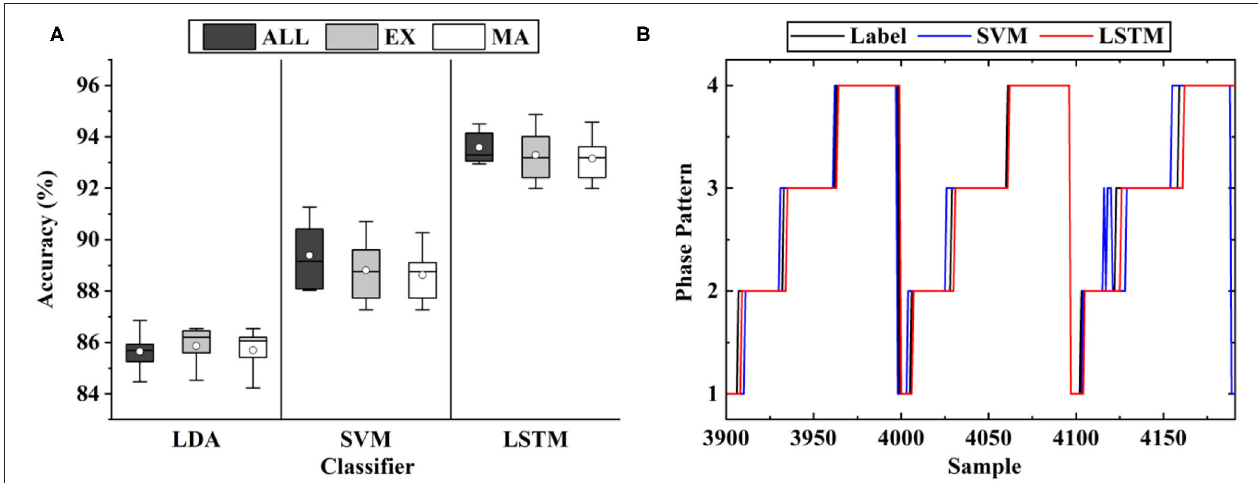
FIGURE 6 | The classification results of gait phases: (A) The results of the different muscle sets, where MA represents the proposed muscle selection scheme, EX represents the exhaustive method and ALL represents all the nine muscles; (B) The representative results of the three classifiers.